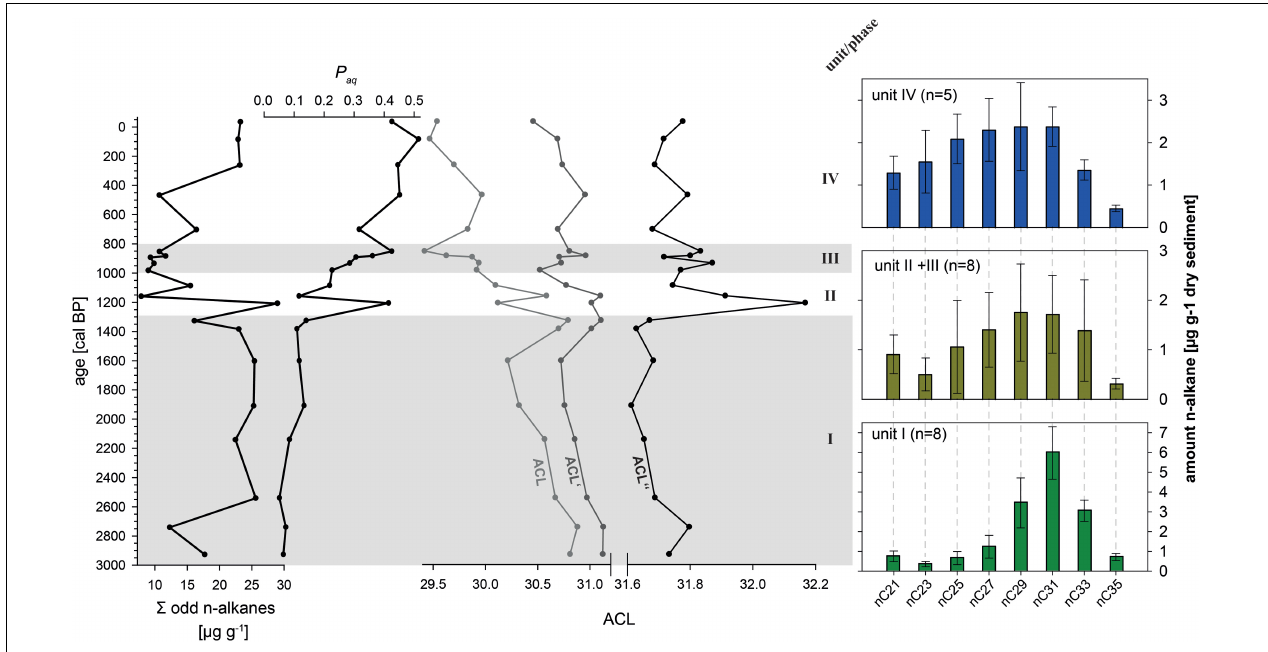
FIGURE 4 | Left plane: Leaf-wax n-alkane indices of composite record AMP-16. Sum of odd n-alkanes (nC21 to nC35), Paq, and average chain length ACL, ACL (cid:48) (nC39-33), and ACL (cid:48)(cid:48) (nC31,33). Right plane: mean n-alkane distribution patterns in respect to the sedimentological units (note that unit II and III were merged due to very similar distribution